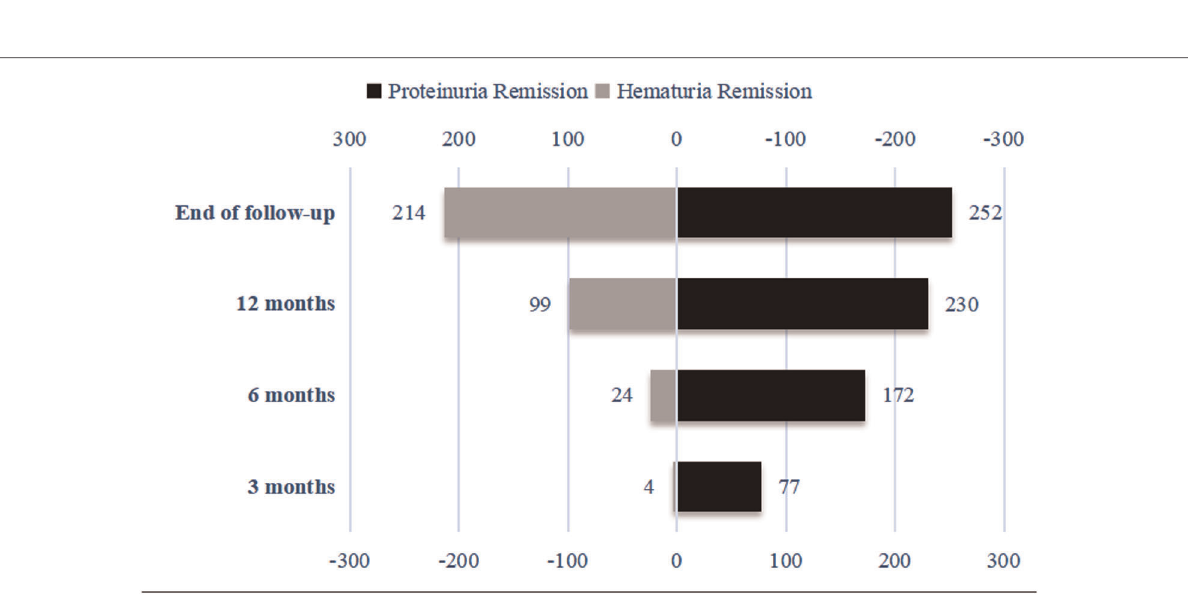
FIGURE 3 Remission of hematuria and